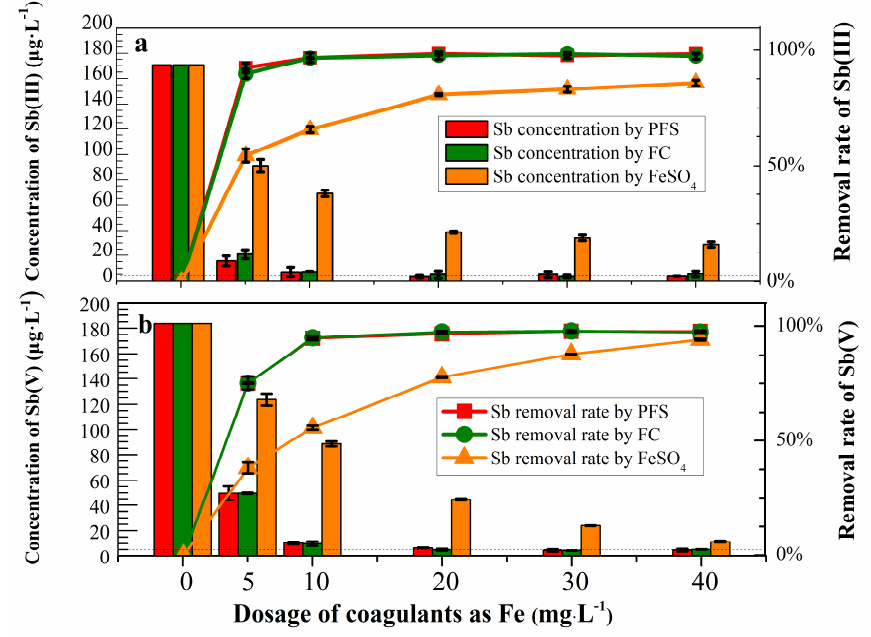
Figure 2. Effects of concentrations of coagulants on the removal of ( a ) Sb(III) and ( b ) Sb(V) by using PFS, FC, and FeSO 4 respectively (initial concentration of Sb(III):176 μg·L −1 ; Sb(V): 185 μg·L −1 ).